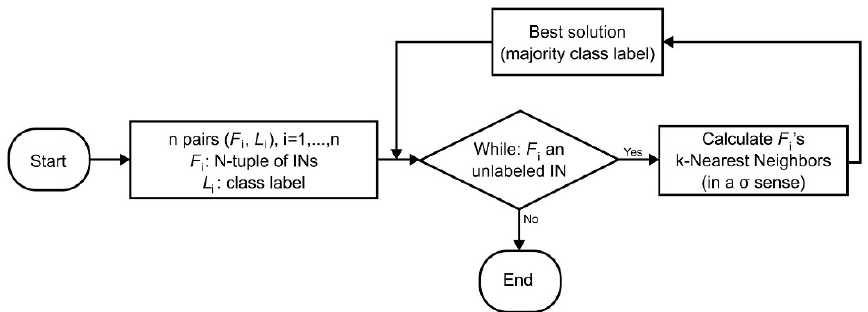
Figure 3. kNN classification scheme for testing.